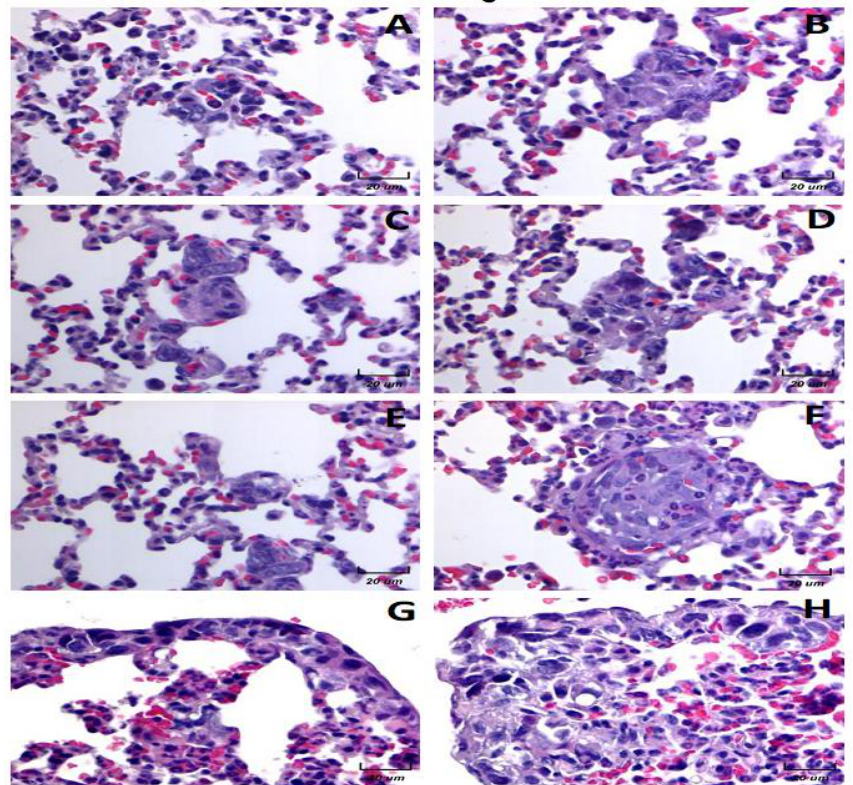
Figure 6. Histological examination of the BPA-treated animals with tumors. Parenchymal ( A – F ) and subpleural ( G , H ) micrometastasis in the lungs of mice neonatally exposed to BPA and orthotopically implanted at eight weeks old with tumor cell line 4T1. Representative images of the lungs of female mice with tumor induction neonatally exposed to BPA at 100× magnification.